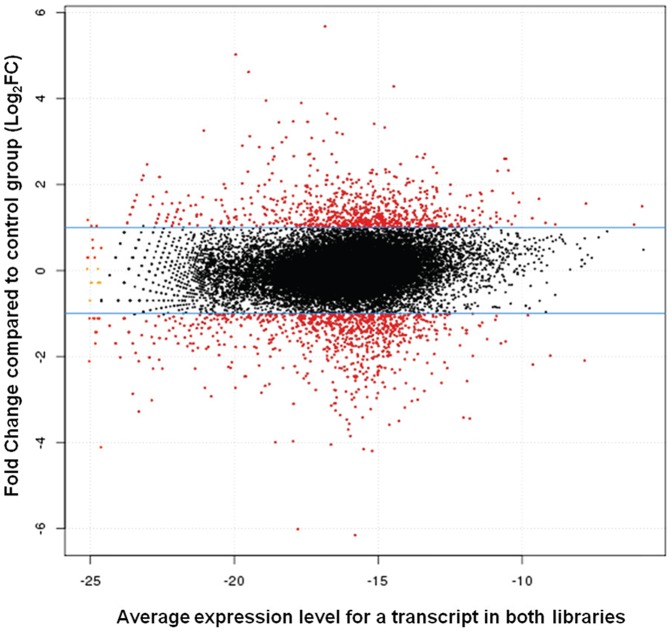
MA-plot of differentially expressed genes in benzo[a]pyrene and phenanthrene-exposed and non-exposed fish.The x-axis is an estimate of the relative abundance of the transcript (a measure of the average expression level for each transcript across the two libraries), and the y-axis is a measure of differential expression (Log2FC). The solid blue horizontal lines show where genes with two-fold differences in expression fell (Log2FC = 1), so all the genes with differential expression in this analysis show at least two-fold differences between treatments (red points).